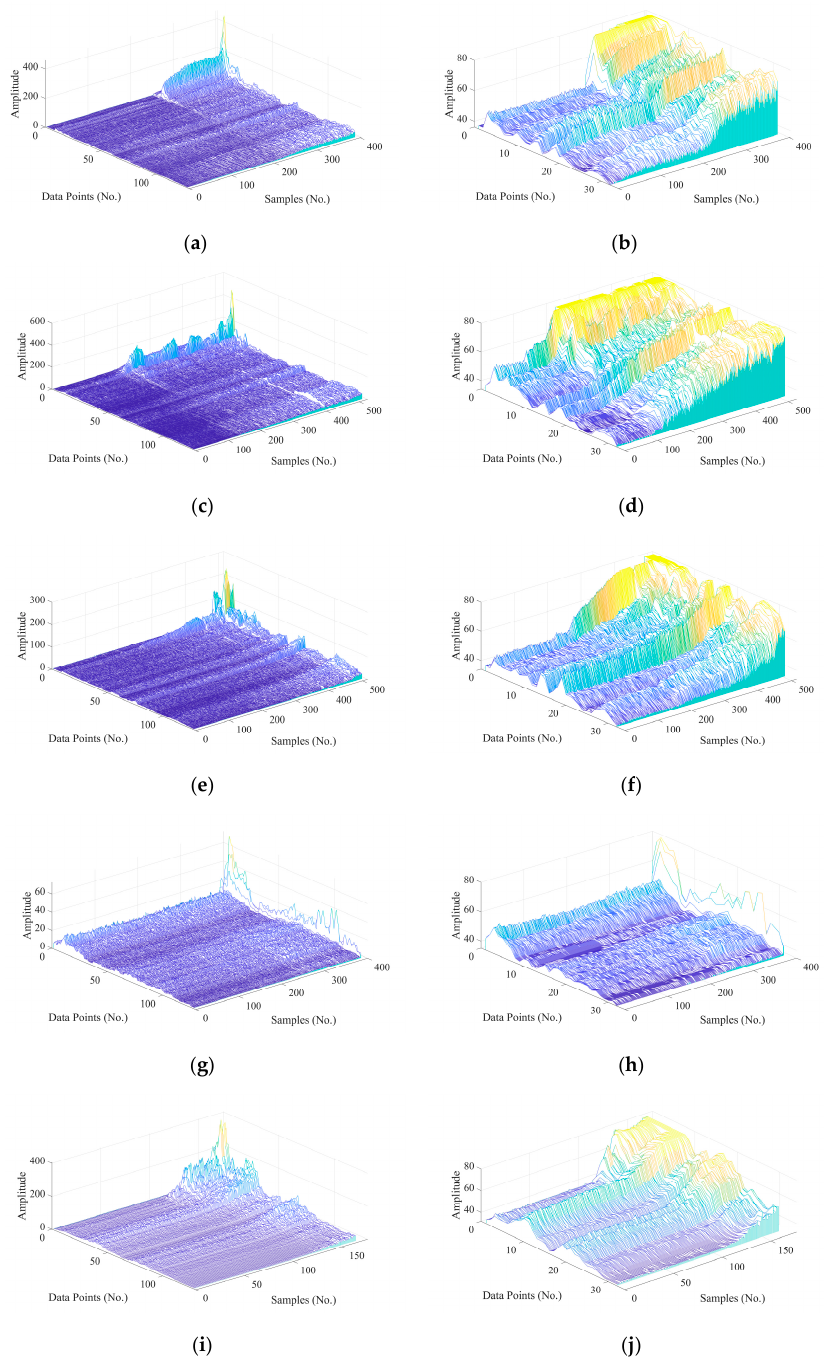
Figure 5. Waterfall plots of sub-band features and corresponding MCHs for signals. ( a ) Sub-band features of Bearing 1_1, ( b ) MCHs of Bearing 1_1, ( c ) sub-band features of Bearing 1_2, ( d ) MCHs of Bearing 1_2, ( e ) sub-band features of Bearing 1_3, ( f ) MCHs of Bearing 1_3, ( g ) sub-band features of Bearing 1_4, ( h ) MCHs of Bearing 1_4, ( i ) sub-band features of Bearing 1_5, ( j ) MCHs of Bearing 1_5.